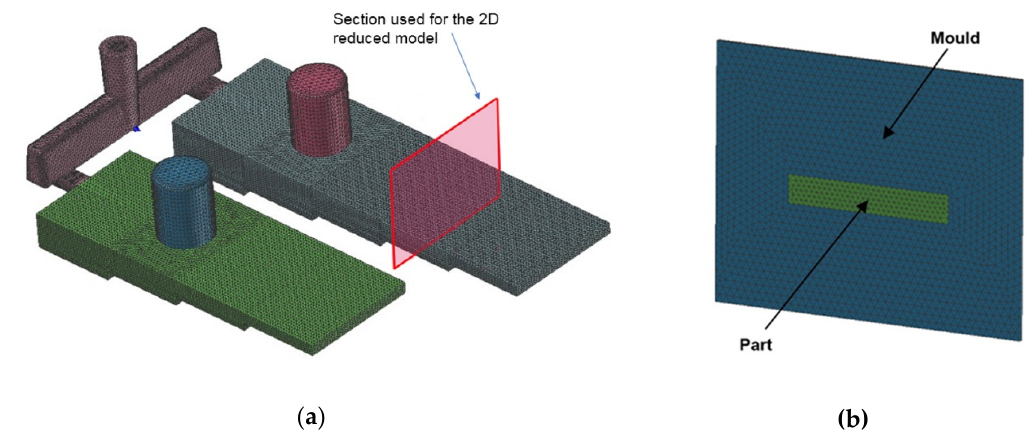
Figure 3. ( a ) Mesh used in the 3D simulation model; ( b ) mesh used in the pseudo-2D model.